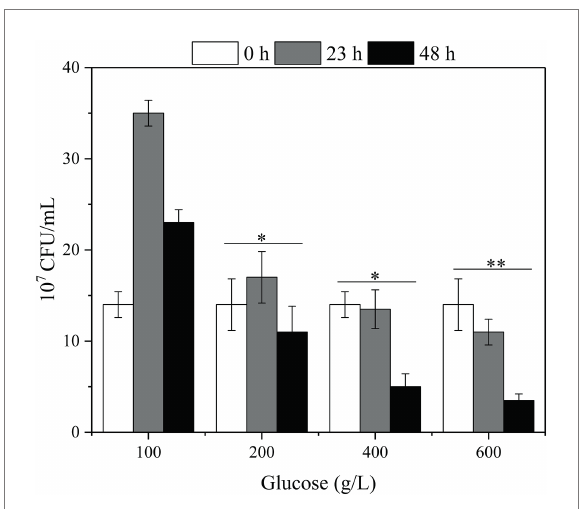
FIGURE 6 The effect of glucose titers on the intra-cellular ATP concentration of the G. oxydans